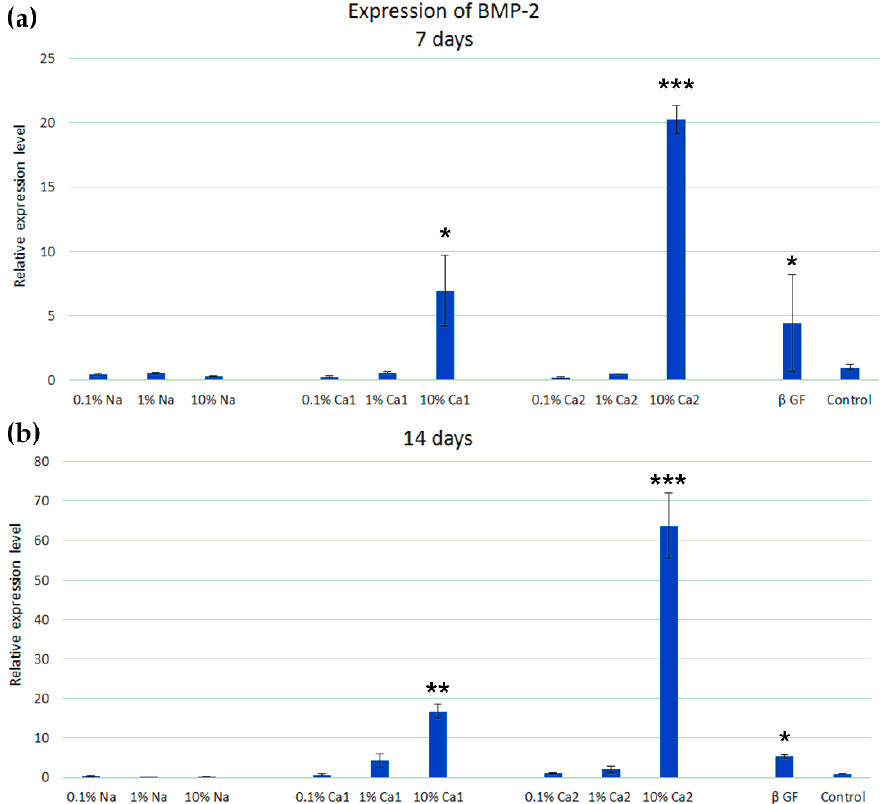
Figure 12. Differentiation of adipose-tissue-derived multipotent mesenchymal stem cells (ADSCs) with the solutions of PEPA salts Na-PEP, Ca1-PEP and Ca2-PEP of different concentrations, in the presence of β -glycerophosphate and in the control experiment in the absence of additives. The ex- pression of the BMP-2 gene in ADSCs on days 7 ( a ) and 14 ( b ). RT-PCR analysis. Statistical differ- ence between a test group and control (* p < 0.05, ** p < 0.01, *** p < 0.001). Reprinted with permis- sion from [125]. Copyright (2019) MDPI.